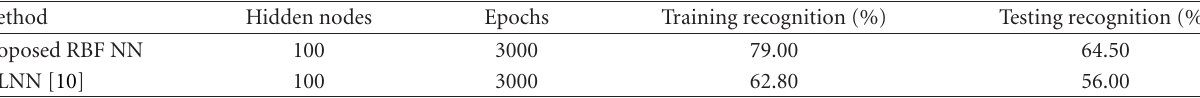
Table 2: Performance comparison for the Lyapunov theory-based neural